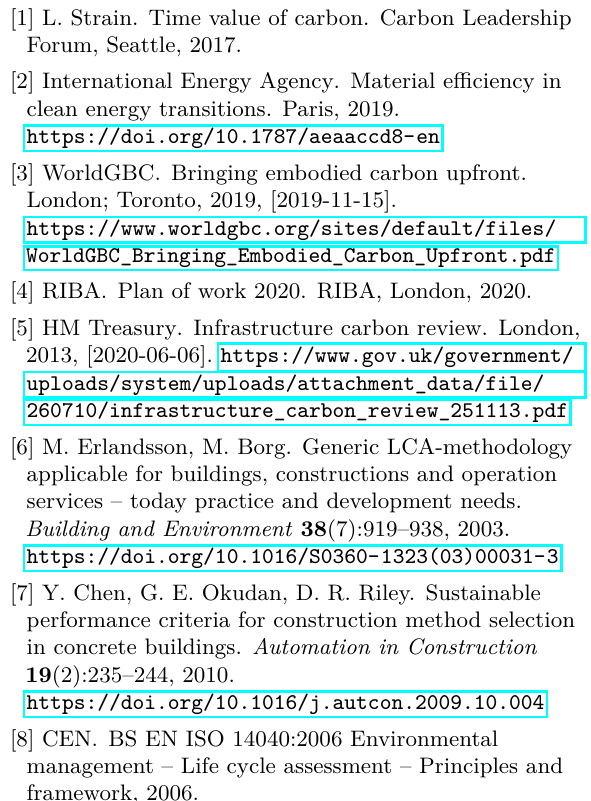
Table 4. Comparison between SLCA (A1–A2) and detailed LCA (A1–A3) results in kg CO compared against that of the detailed LCA in Table